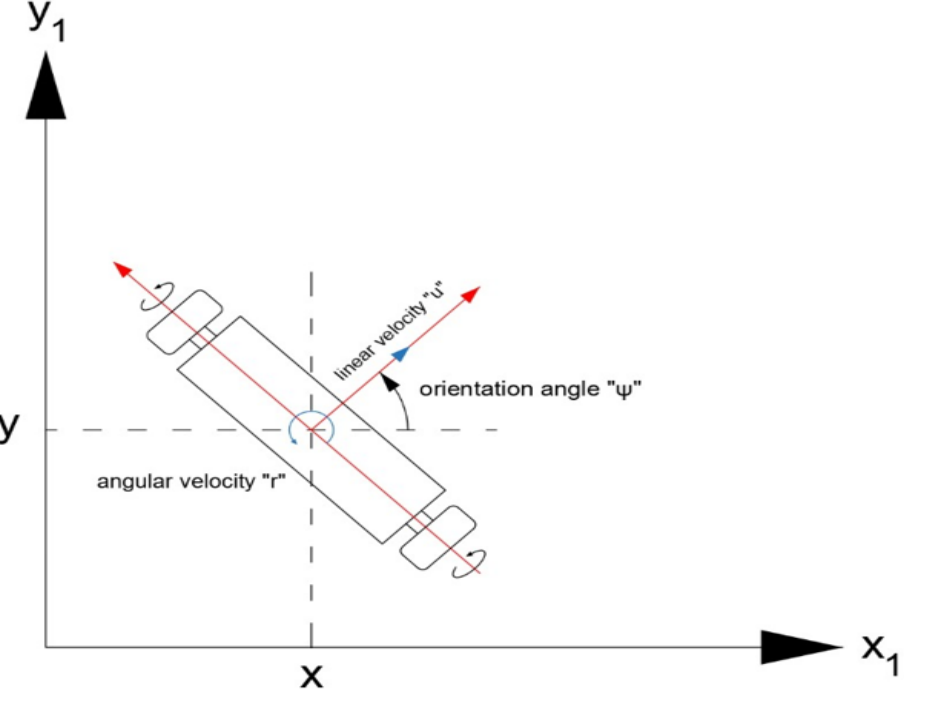
angle, are represented by Equations